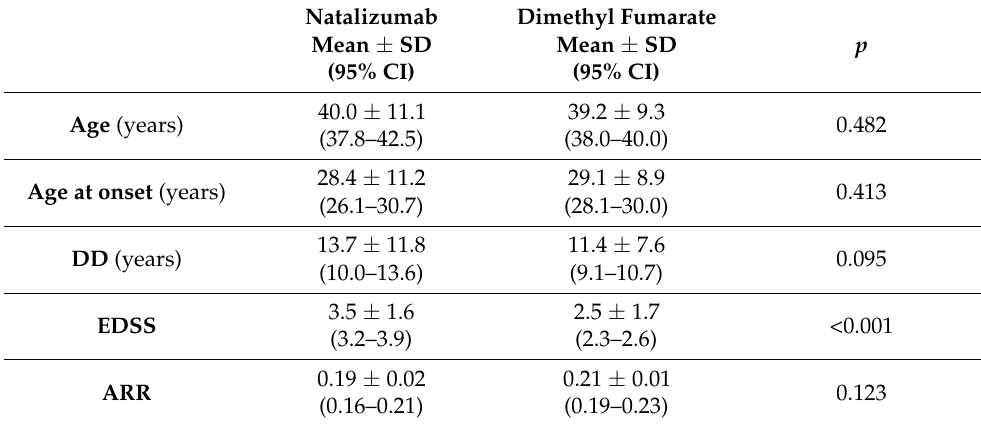
Table 1. Demographic and pathological characteristics of treated MS populations. DD—Disease Dura- tion; EDSS—Expanded Disability Status Scale; ARR—Annual Relapse Rate; MS—Multiple Sclerosis.